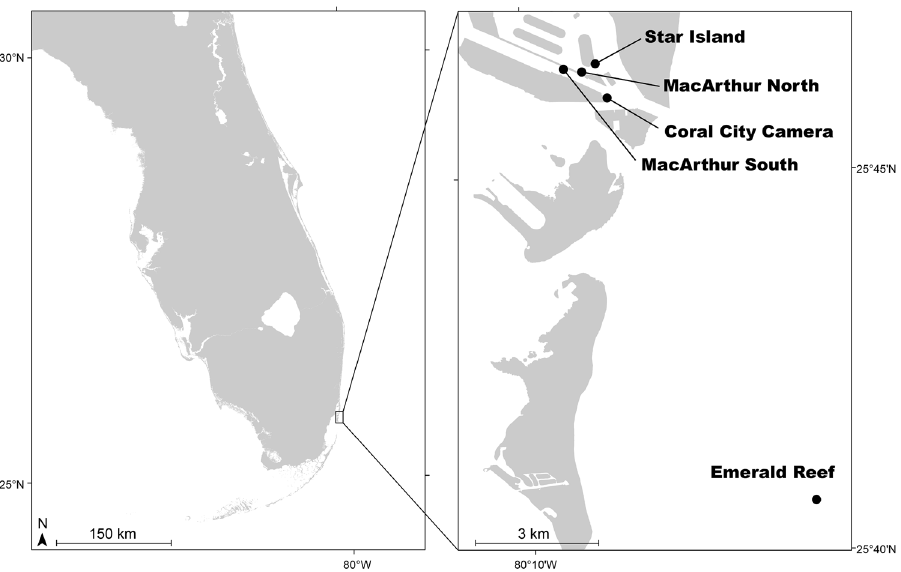
Figure 1. Map showing South Florida and the Port of Miami study region including the location of three inshore, urban monitoring sites (Star Island, MacArthur North, MacArthur South), the Coral City Camera site used for fish monitoring, and the more-natural Emerald Reef site. Figure produced using Illustrator (v24.3,